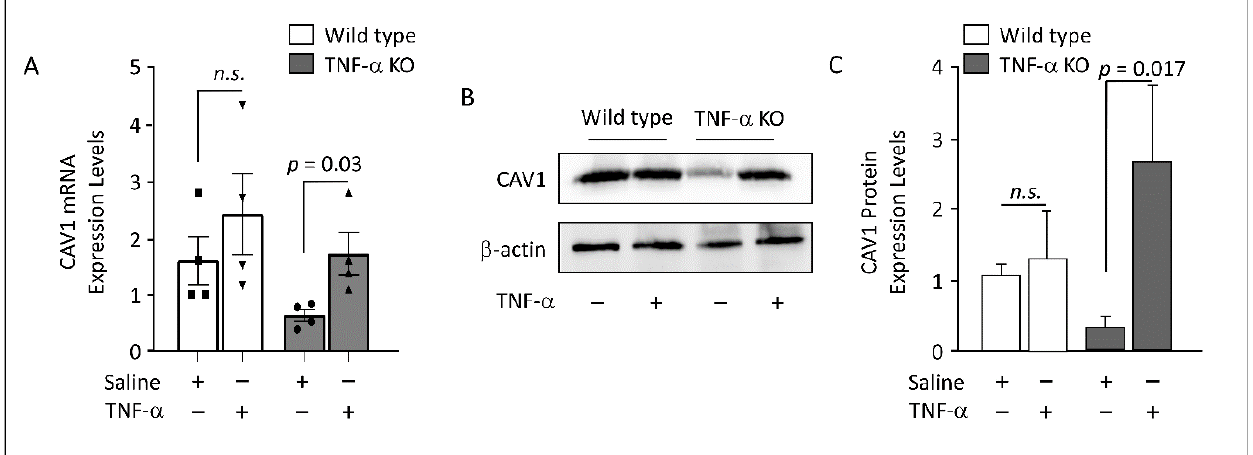
Figure 3. Exogenous administration of TNF- α induces CAV1 expression in vivo. ( A ). The levels of mRNA of CAV1 in subcutaneous adipose tissue obtained from wild-type and TNF- α knock-out mice injected intraperitoneally with saline or TNF- α solution (100 µg/kg). Data are presented as mean ± SEM values of four animals/group. Two-tailed unpaired Student’s t -test was used to determine significance. ( B , C ). Western blots for total protein extracts (10 µg) were developed with antibodies against CAV1 and β -actin, as indicated. CAV1 expression was significantly elevated in response to TNF- α treatments. Two-tailed unpaired Student’s t -test was used to determine significance. Statistical analyses were relative to untreated wild-type animals (n = 4).